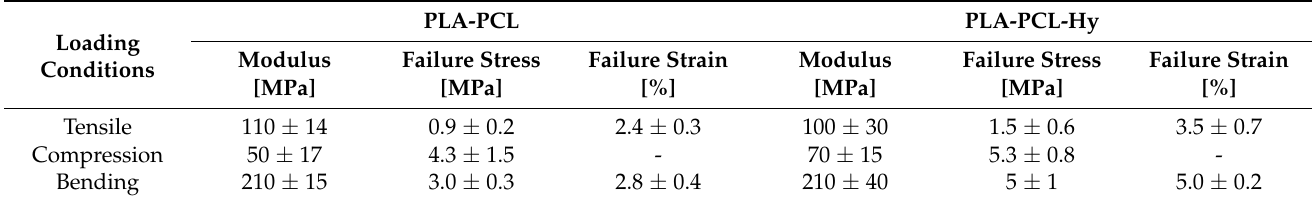
Figure 4. Stress vs. strain curves for specimens of PLA-PCL and PLA-PCL-Hy measures in ( A ) tensile, ( B ) compression, and ( C ) bending tests. Table 2. Stiffness, strength and failure strain of PLA-PCL and PLA-PCL-Hy.